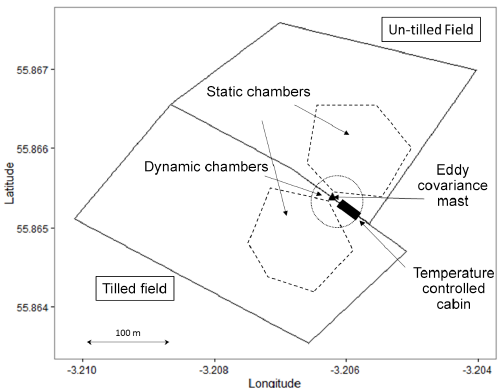
Figure 1. N 2 O fluxes were measured from two adjacent grassland fields at the Easter Bush Farm (Penicuik, Scotland). The “North” field remained untilled, while the “South” field was ploughed on 1 May 2012. An eddy covariance mast was set up next to a perma- nent cabin positioned between the fields. Dynamic chamber mea- surements were made within a 30m radius of the cabin. Static chambers were located within the fetch of the eddy covariance mast and moved